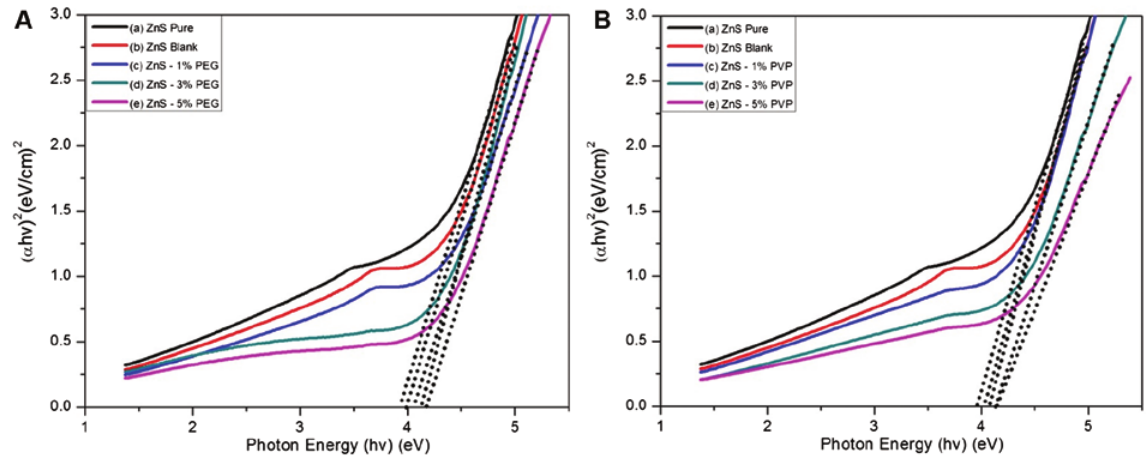
Figure 4: Tauc plot of the free/uncapped (a) blank (b) ZnS nanoparticles capped with (c) 1%, (d) 3%, and (e) 5% PEG (A) and PVP (B).